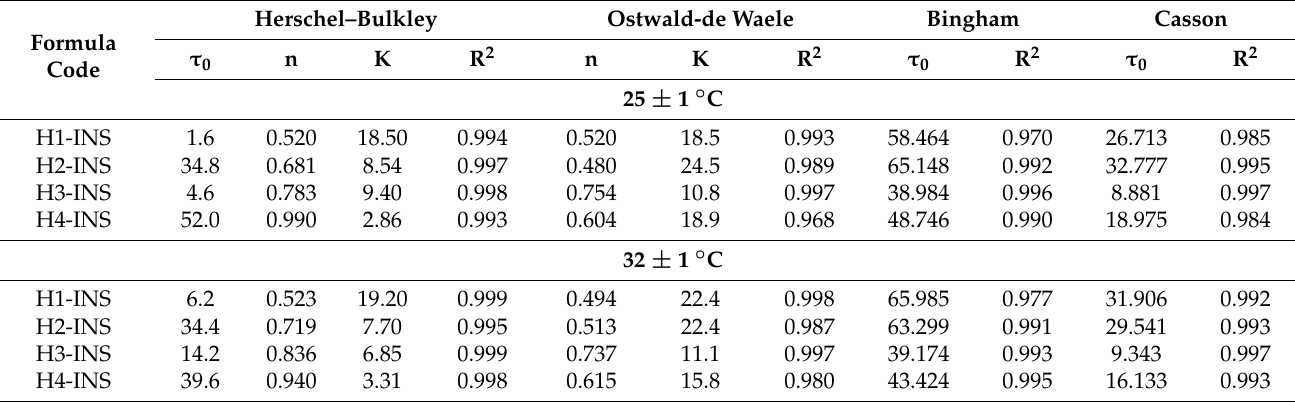
Table 5. The results obtained from mathematical modeling of